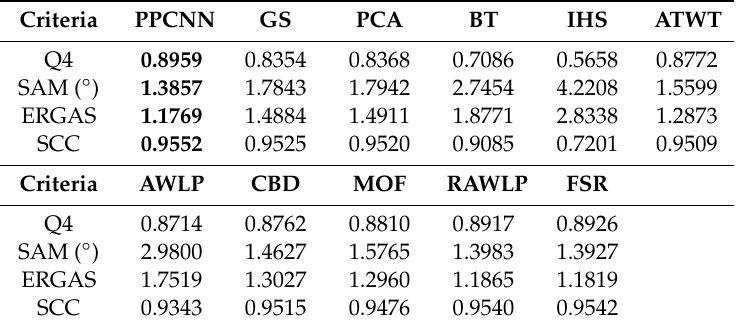
Figure 11. Pansharpening results of Sichuan dataset. ( a ) MS. ( b ) Ground-truth image. ( c ) PPCNN. ( d ) GS. ( e ) PCA. ( f ) BT. ( g ) IHS. ( h ) ATWT. ( i ) AWLP. ( j ) CBD. ( k ) MOF. ( l ) RAWLP. ( m ) FSR. Table 3. Comparison results for Sichuan